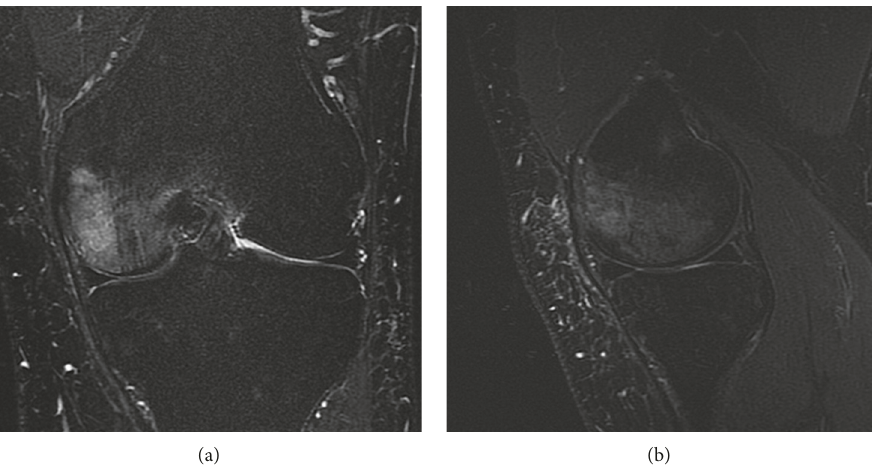
Figure 5: (a) Coronal and (b) sagittal images of right knee showing lateral femoral condyle marrow oedema.